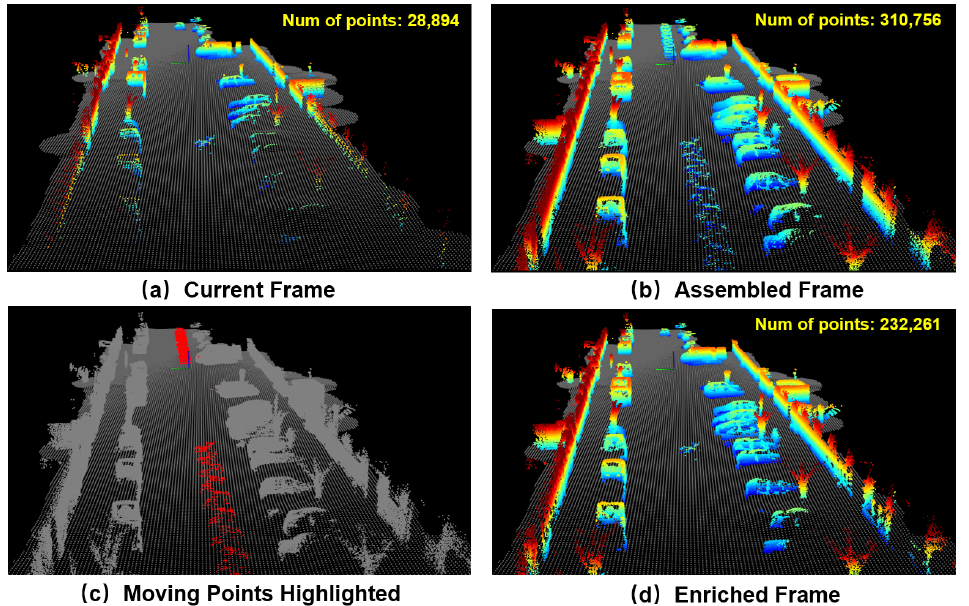
Figure 1. The current LiDAR frame (shown in ( a )) only contains 28,894 non-ground points that are considered sparse. By assembling consecutive frames together, a denser representation can be obtained, as shown in ( b ). However, moving objects (highlighted as red points in ( c )) leave “ghost” tracks in the assembled frame. Using the method proposed in this paper, these “ghost” tracks are successfully removed while the static environment is safely enriched, as shown in ( d ). The method proposed in [13] is utilized for ground/non-ground classification. The estimated ground surface is shown as gray points, while non-ground points are colored by